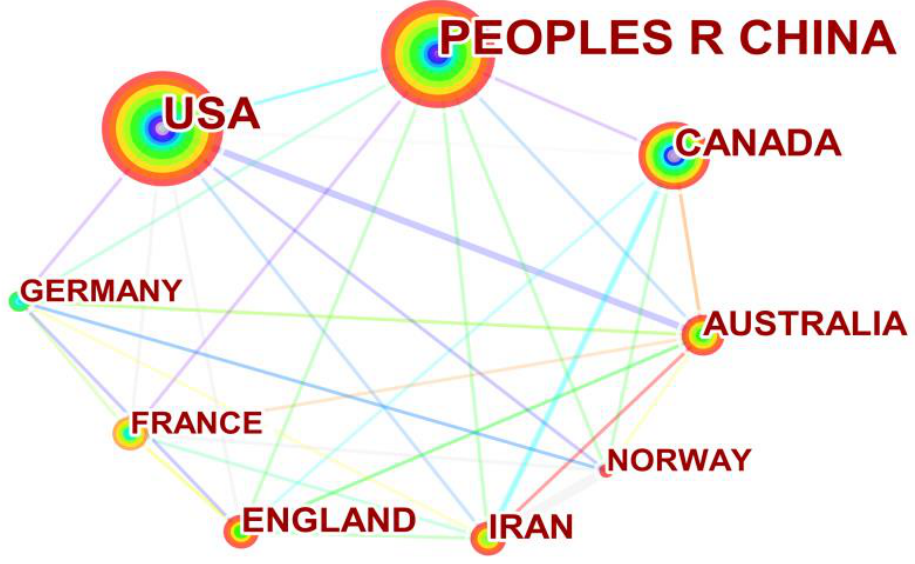
Figure 4. Country cooperation network.